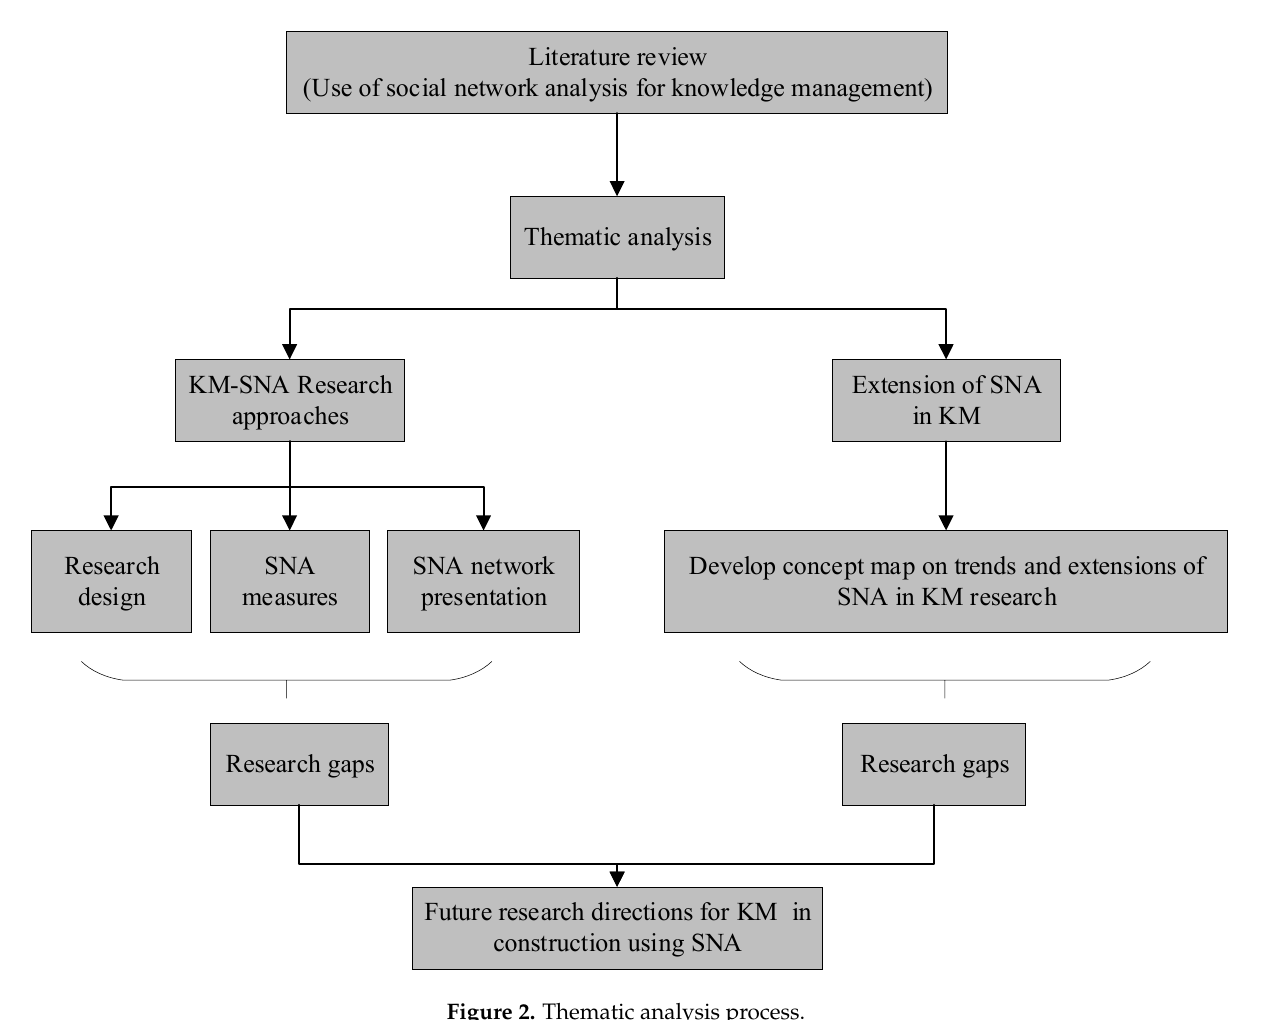
Figure 2. Thematic analysis process.